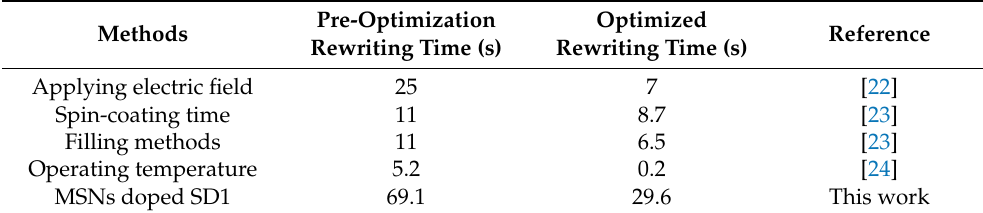
Figure 3. SEM images of the different SD1-MSNs composite films on glass substrates. Table 1. Comparison of rewriting time of this work and several reported